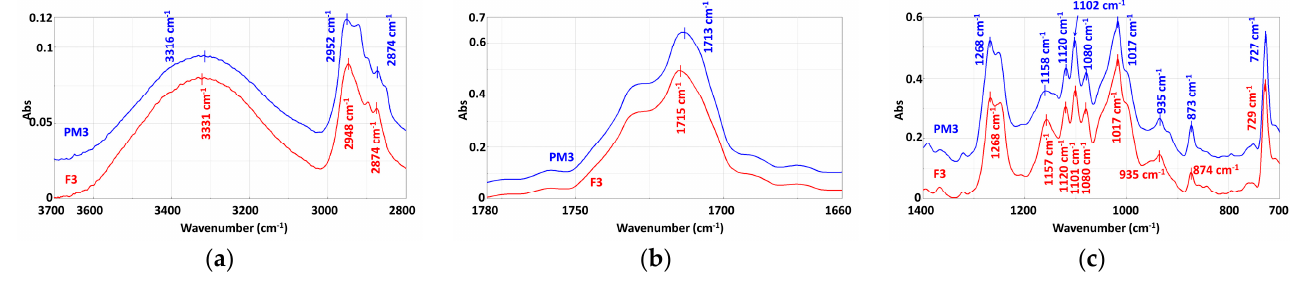
Figure 9. FTIR spectra of the F3 and PM3 compounds: ( a ) 3700–2800 cm − 1 ; ( b ) 1780–1680 cm − 1 ; ( c ) 1400–700 cm − 1.